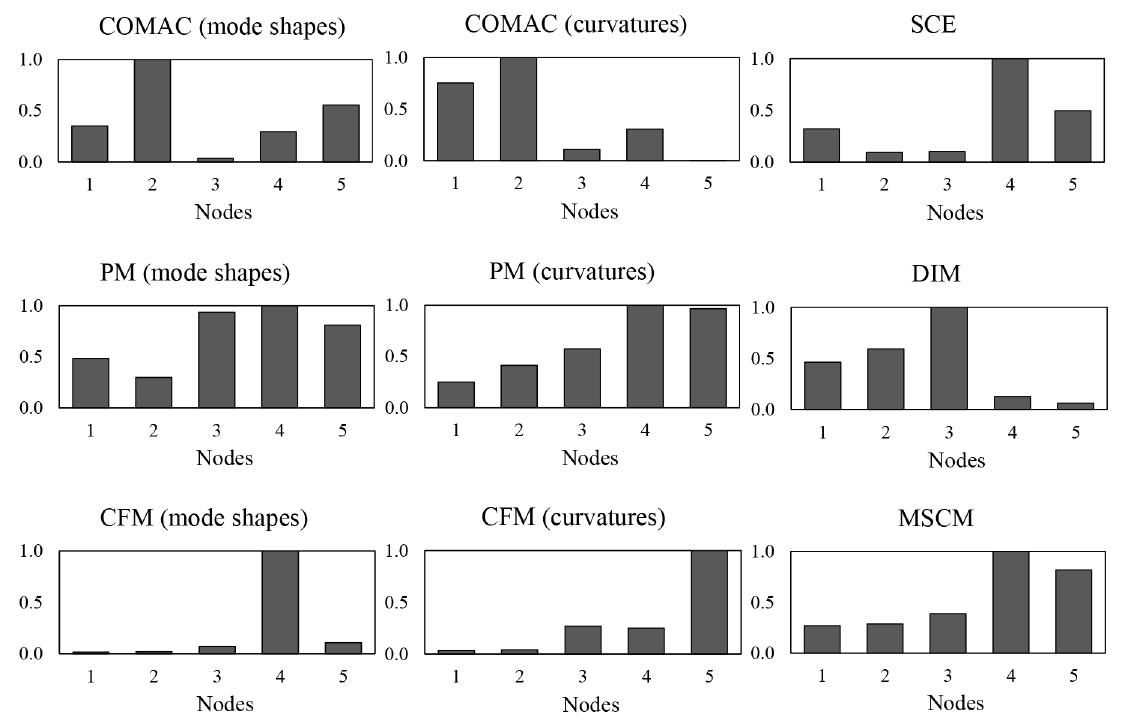
Figure 13. Damage localisation in y direction by selected modal-based